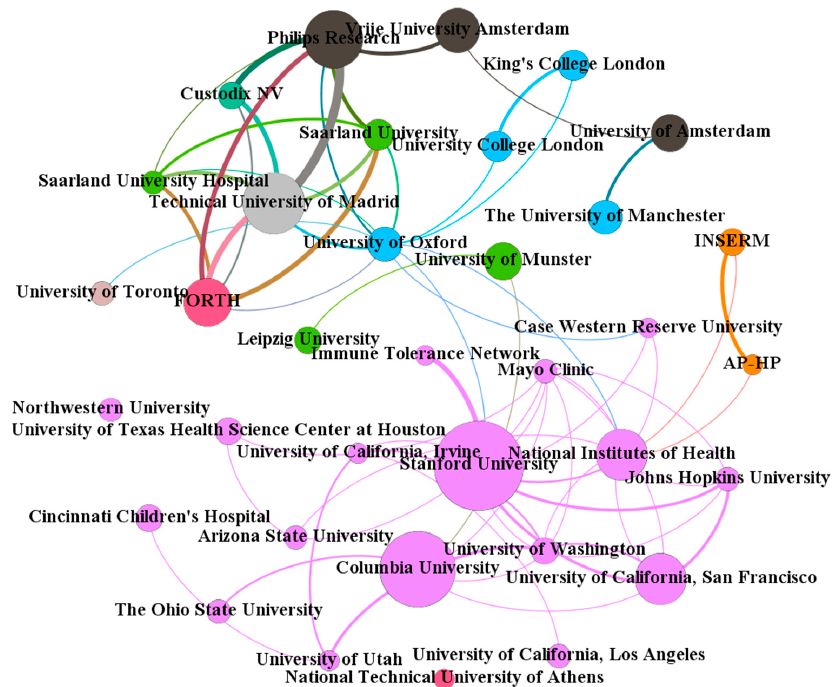
Figure 3. Collaboration network among institutions with ≥ 5 articles.